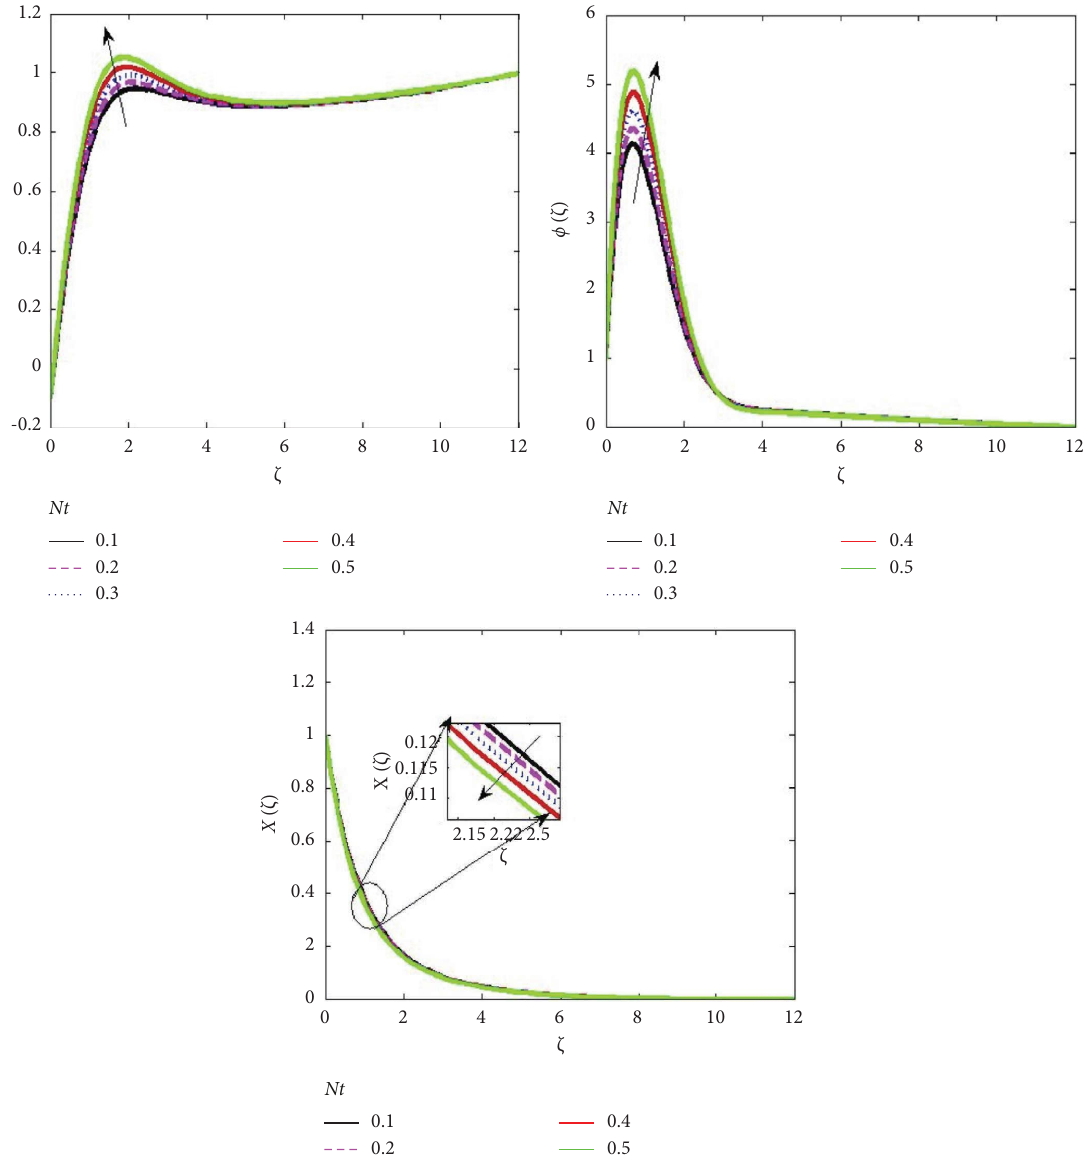
Figure 8: Efect of the thermophoresis parameter on the velocity, concentration, and motile density